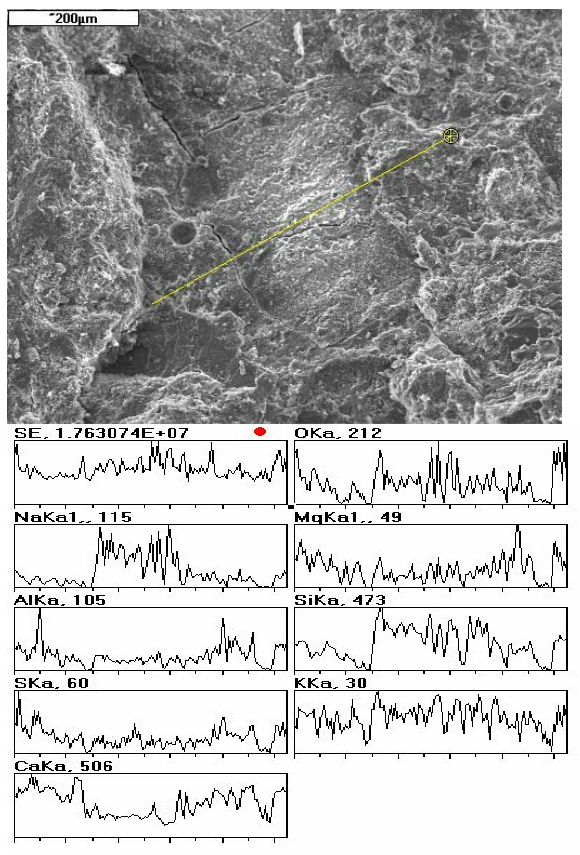
Fig 7. SEM image of reaction product in a mortar with hornstone aggregate and line profile of Ca, Si, Na, K, S,